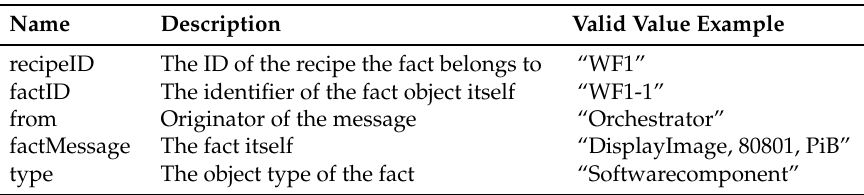
Table 1. Field names of the Drools Fact object in the addFact